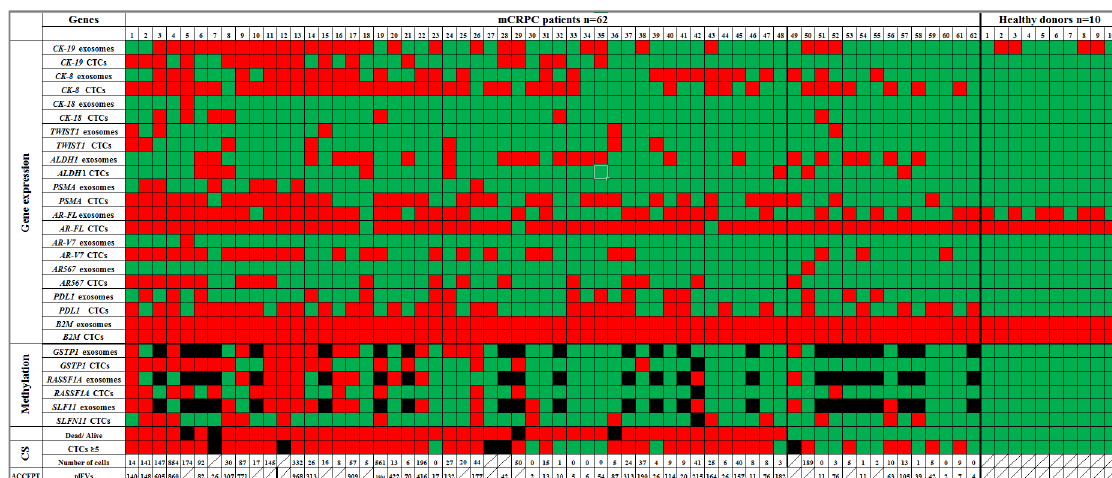
Figure 2. Heatmap: Direct comparison of gene expression and DNA methylation markers in circulating tumor cells (CTCs) and paired plasma-derived exosomes in mCRPC patients and HD.